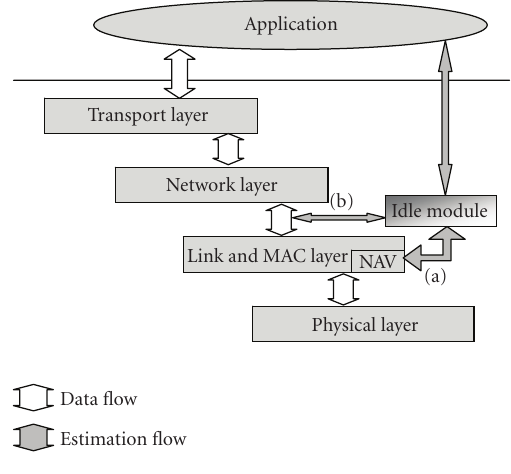
Figure 3: Architecture of idle